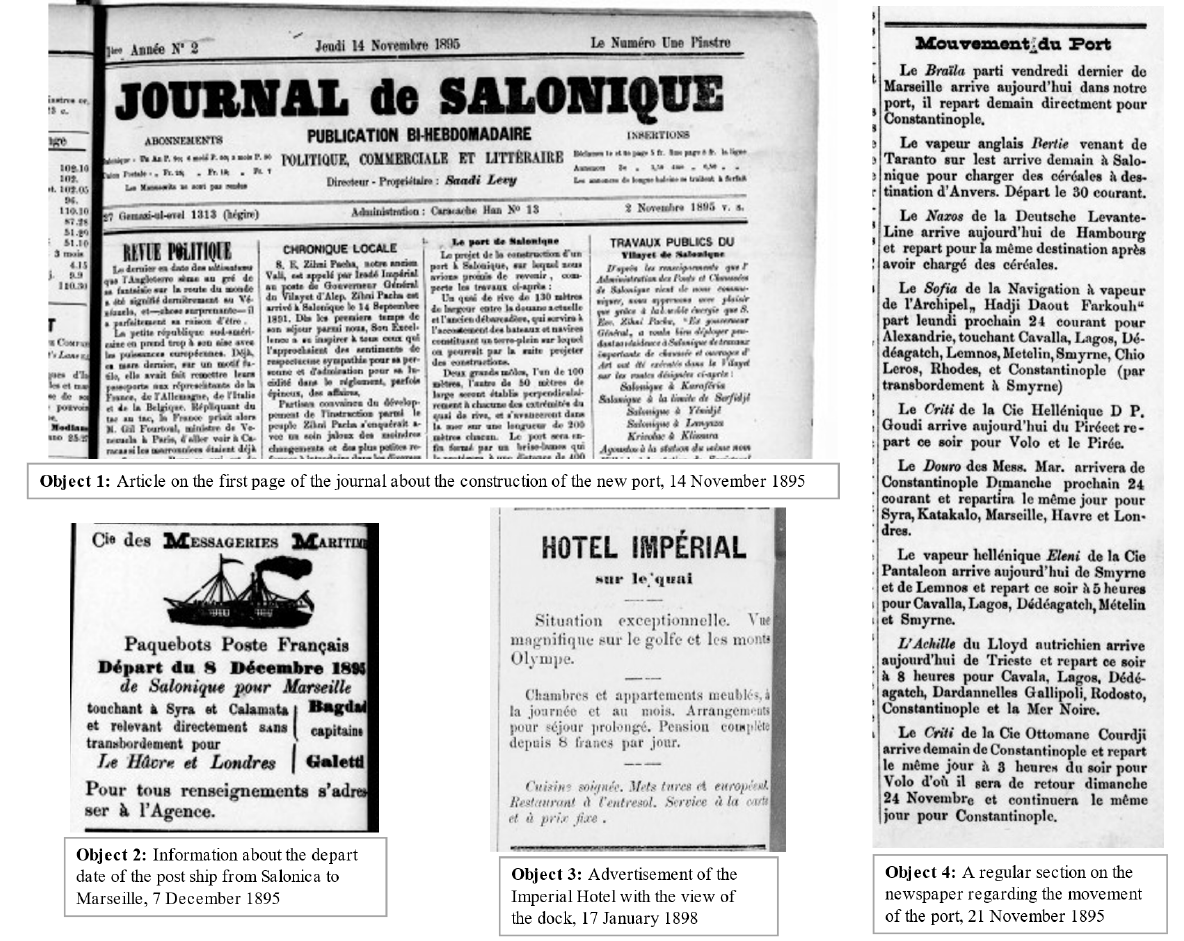
Excerpts about the port of Salonica from Journal de Salonique, ©BnF,